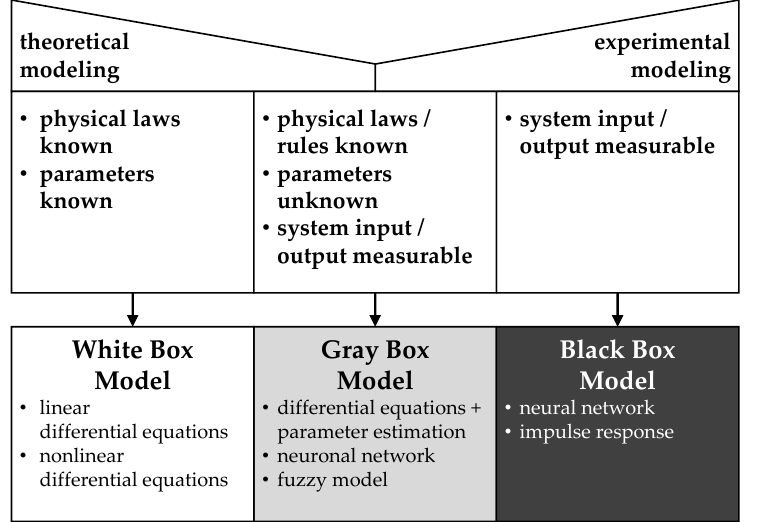
Figure 4. Detail level of mathematical models categorized in white box, gray box and black box models, modified according to [34].